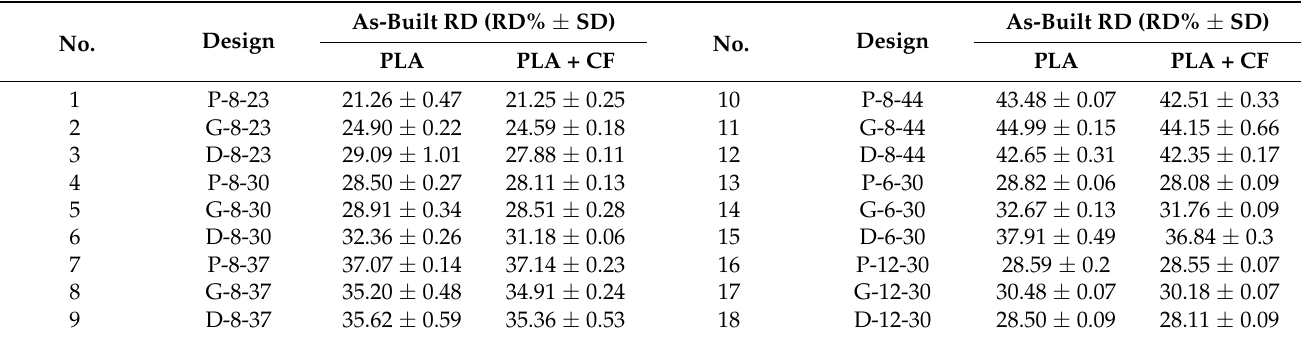
Table 5. Relative densities of the Diamond, Gyroid, and Primitive at different unit cell sizes and designed relative